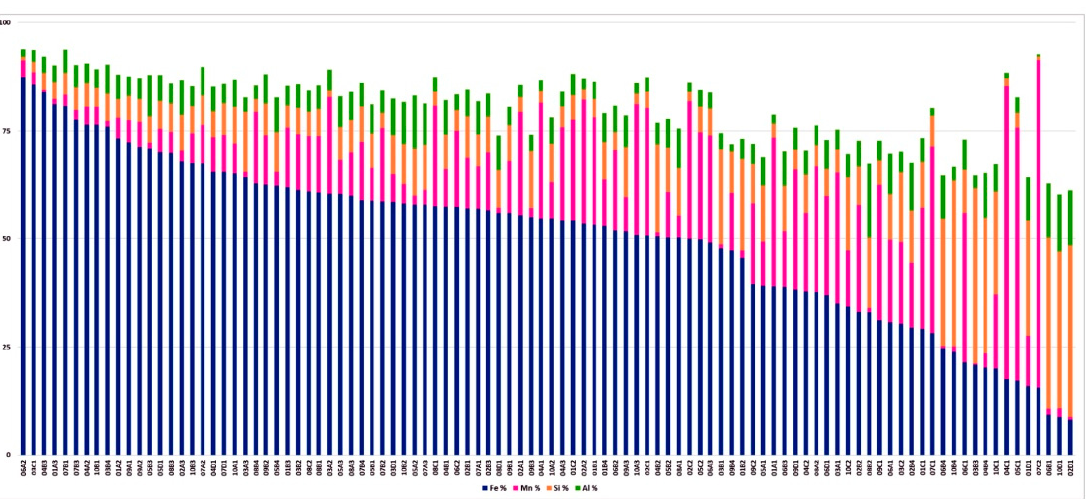
Figure 4. Chemical composition summary of 100 samples. The main elements are iron, manganese, silica and aluminum.